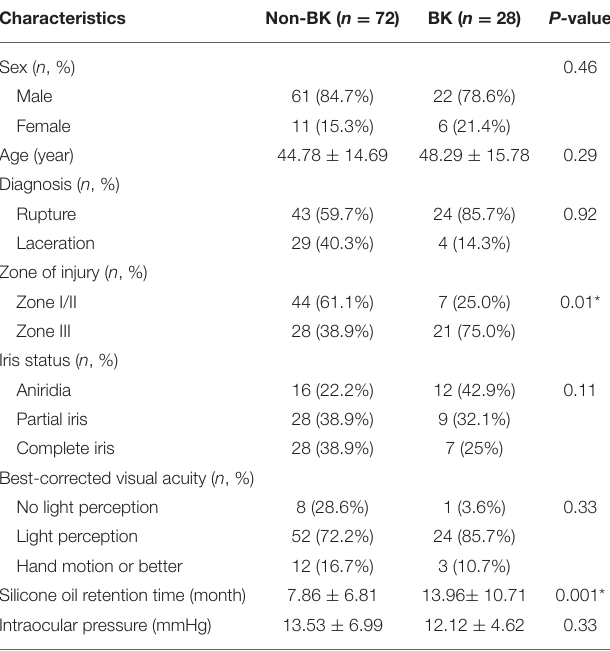
TABLE 1 | Demographic and clinical characteristics of the study population.